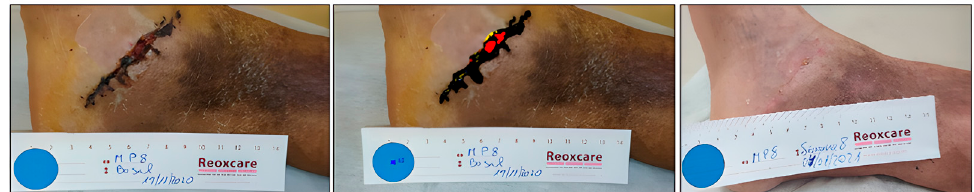
Figure 3. Healing evolution case 2: Baseline assessment ( left ), Baseline HELCOS analysis ( centre ), Week 8 assessment ( right